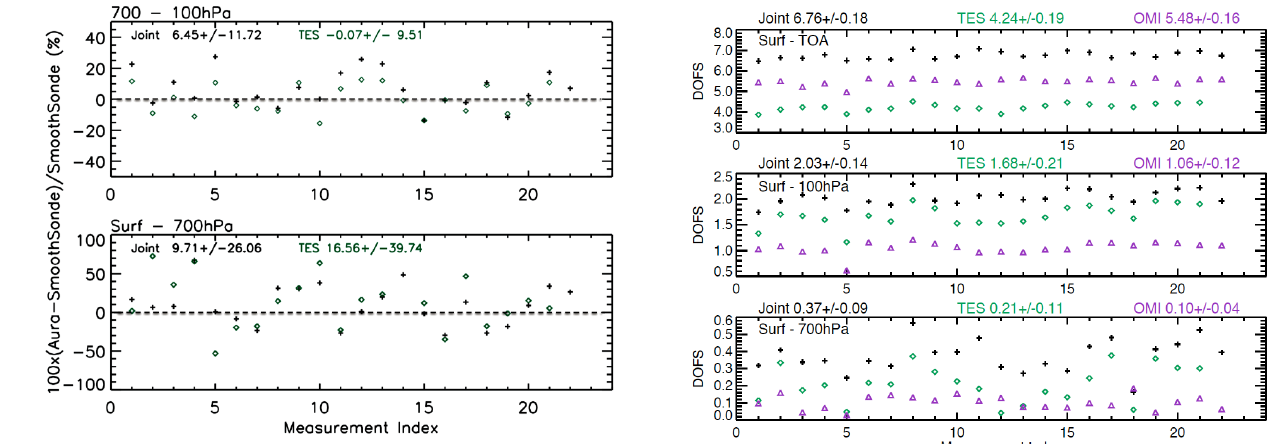
Figure 6 . Percentage differences between Aura measurements and ozonesonde measurements 2 Fig. 6. Percentage differences between Aura measurements and in the troposphere: Joint TES and OMI (black plus), TES only (green diamonds). The TES 3 ozonesonde measurements in the troposphere: Joint TES and OMI only together with joint TES and OMI retrievals use the constraint matrix created from the 4 (black pluses), TES only (green diamonds). The TES only together MOZART3 ozone climatological covariance. Each scene listed in Table 2 is identified by the 5 with joint TES and OMI retrievals use the constraint matrix cre- measurement index in the X axis. A priori ozone profile varies for each scene. The averaging 6 ated from the MOZART3 ozone climatological covariance. Each kernels of Aura measurements were applied to the ozonesonde measurements. 7 scene listed in Table 2 is identified by the measurement index in the x-axis. A priori ozone profile varies for each scene. The averag- ing kernels of Aura measurements were applied to the ozonesonde measurements.